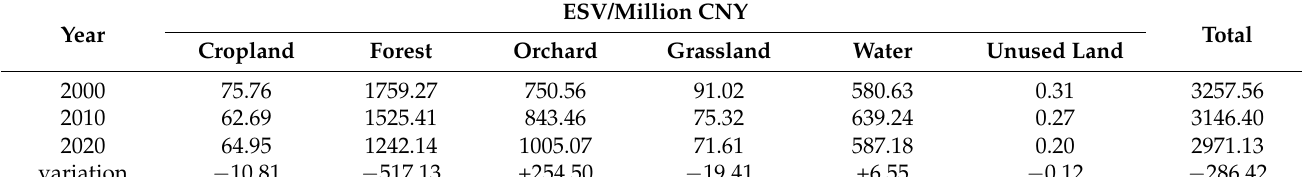
Table 7. The total static ESV in 2000, 2010 and 2020.